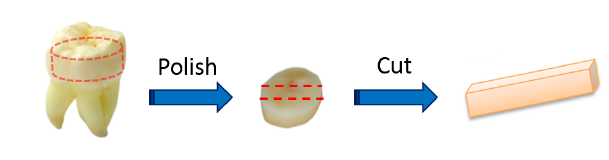
Figure 4. Scheme of sample preparation.